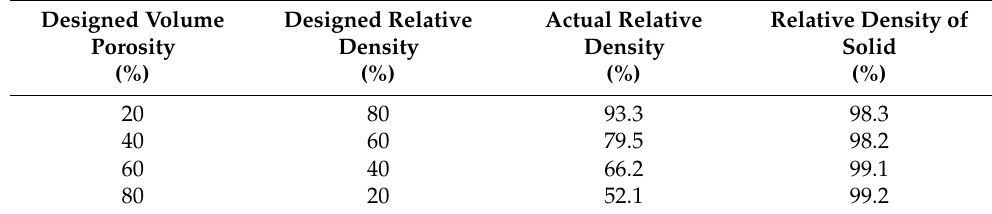
Table 1. Parameters of the as-built porous CoCrMo alloys.